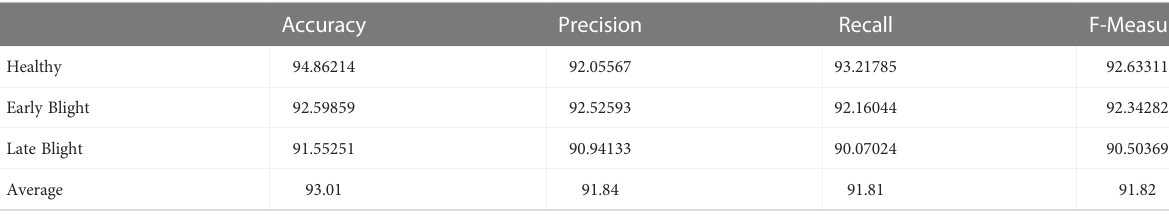
TABLE 9 Detail Performance by class for potato disease detection.